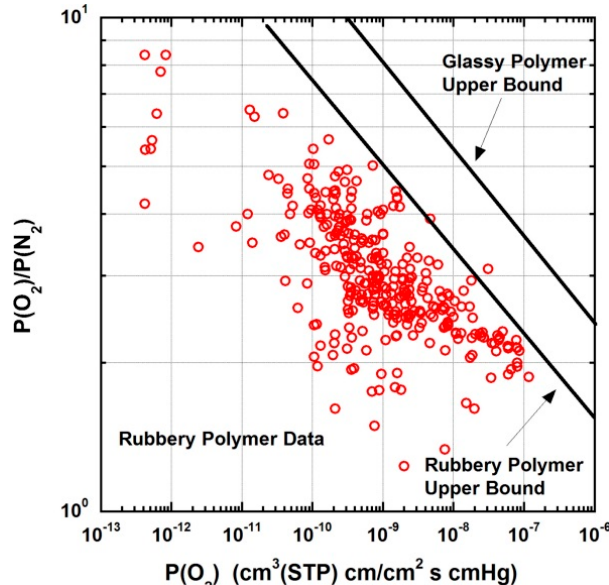
Figure 2. Permselectivity performance of glassy polymers in comparison to rubbery polymers for O 2 / N 2 separation. Adapted with permission from [15].